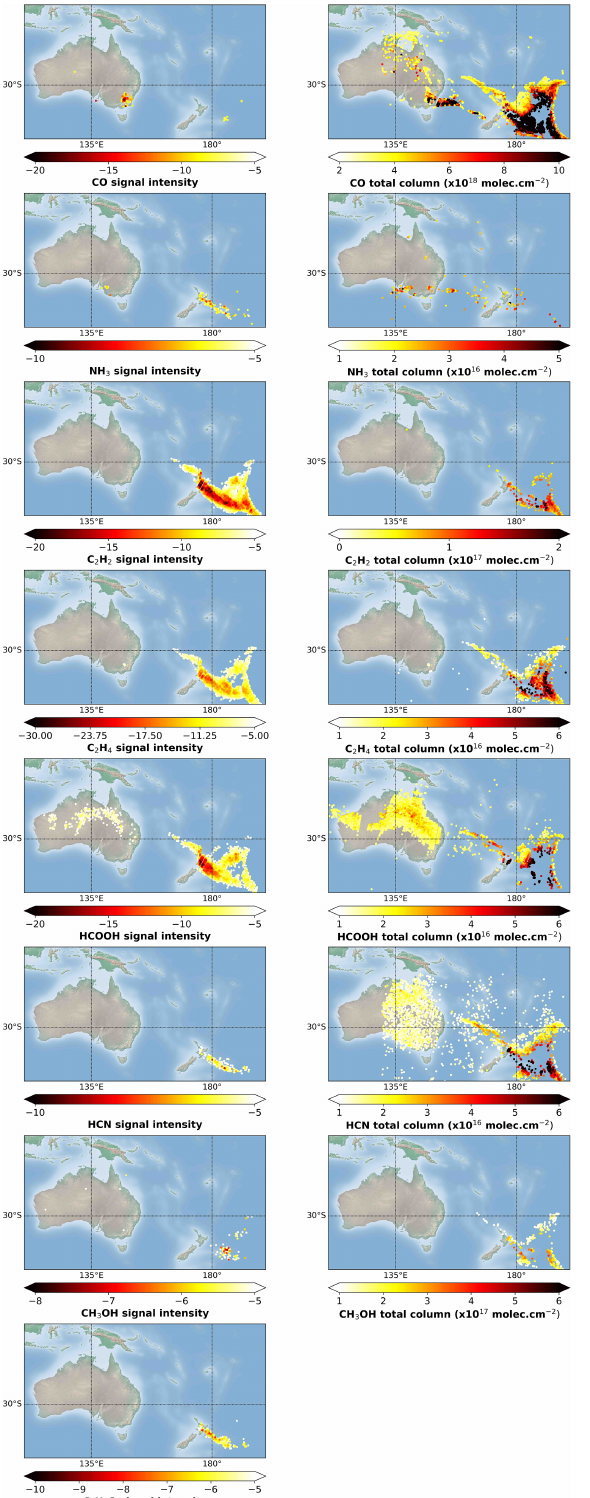
Figure 9. The left column shows the spatial distribution of the residual values associated with CO, NH3, HCN, C 2 H 2 , C 2 H 4 , CH 3 OH, HCOOH, and C 4 H 4 O detections from IASI/Metop-B L1C data during the intense fire event in Australia on 1 January 2020 in the morning (daytime or AM orbit). The right column shows the same as the left column for the total column L2 data. There is no map of C 4 H 4 O total column L2 data because there is no retrieval information